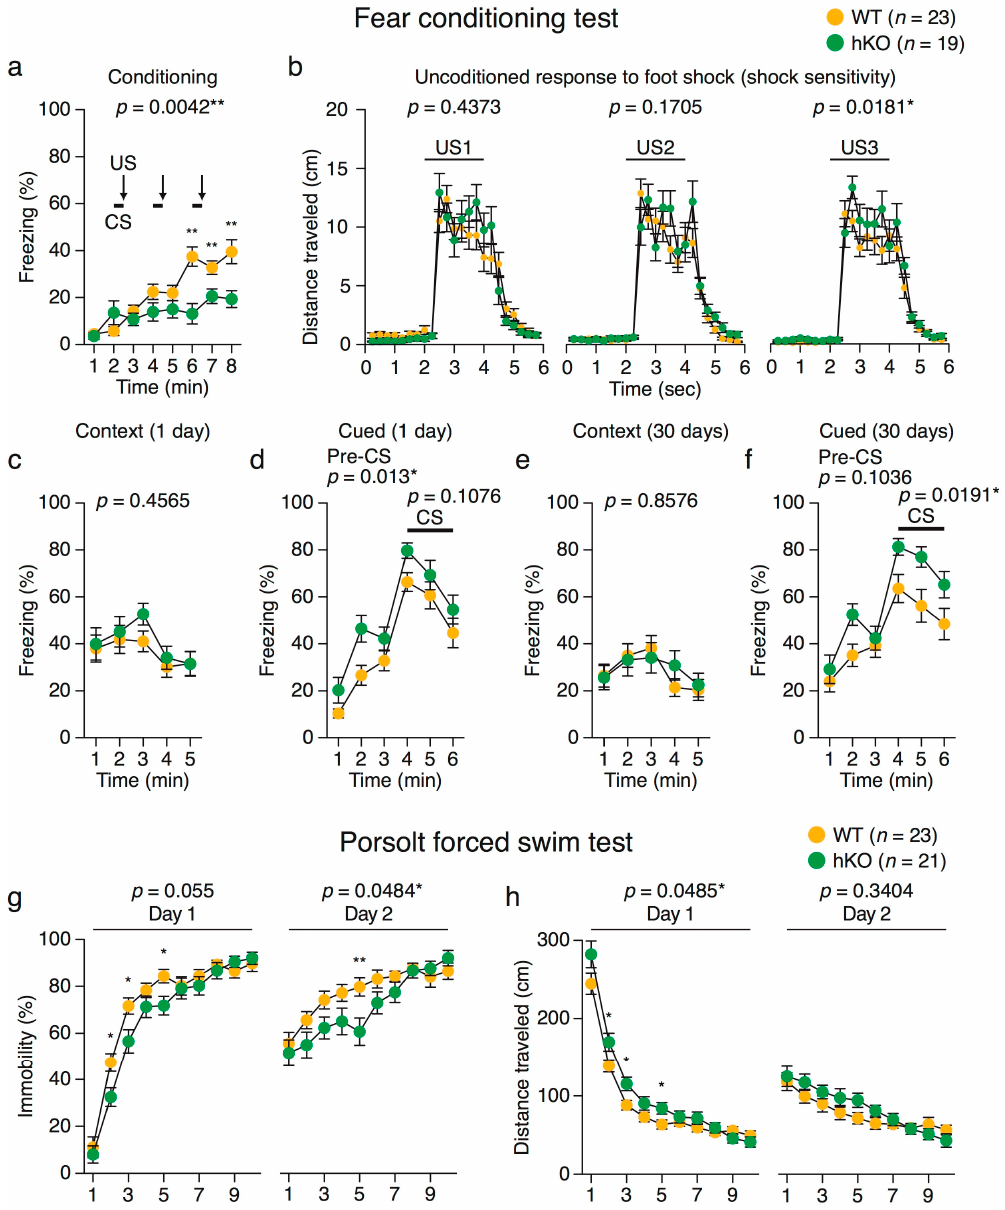
Figure 3. Fear memory and depression-like behavior in Arid1b hKO mice. ( a – f ) Fear conditioning test; ( a ) percentage of freezing in the conditioning session, in which both conditioned stimulus (CS; white noise) and unconditioned stimulus (US; foot shock) were presented; ( b ) distance traveled during and after foot shocks; ( c , d ) context and cued tests one day after conditioning; ( e , f ) context and cued tests 30 days after conditioning; ( g , h ) Porsolt forced swim test; ( g ) percentage of immobility time on Days 1 and 2; ( h ) Distance traveled on Days 1 and 2. Data in the fear conditioning test (WT, n = 23; Arid1b hKO, n = 19) and the Porsolt forced swim test (WT, n = 23; Arid1b hKO, n = 21) are expressed as the mean ± SEM. Significant differences between genotypes are indicated with * p < 0.05 and ** p < 0.01, as determined by two-way repeated-measures ANOVA ( a – h ).